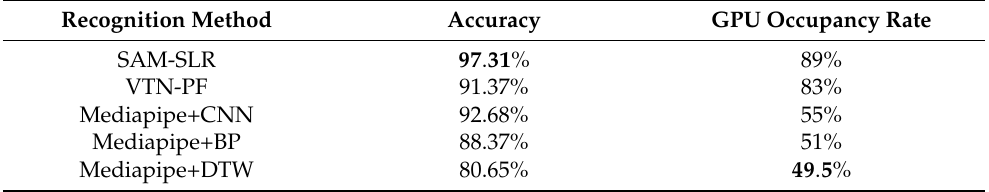
Table 5. Testing results of different gesture recognition methods on the AUTSL